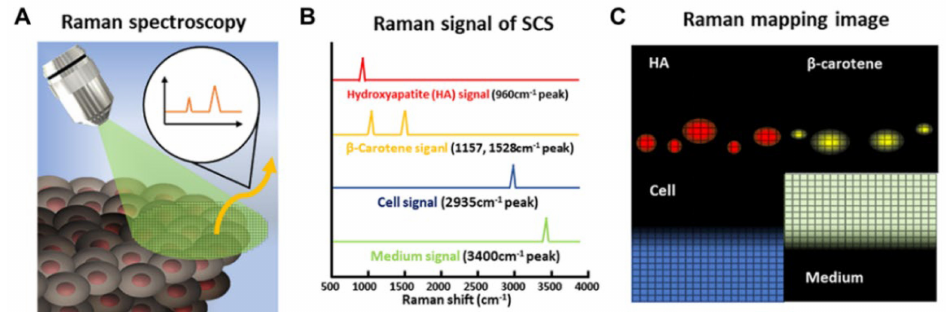
Figure 4. ( A ) Schematic illustration of 3D Raman mapping-based analytical method. ( B ) Characteristic peak of HA, β -carotene, cell, and medium. ( C ) 3D Raman mapping using specific peaks. Adapted with permission from Ref. [176]. Copyright 2021 American Chemical